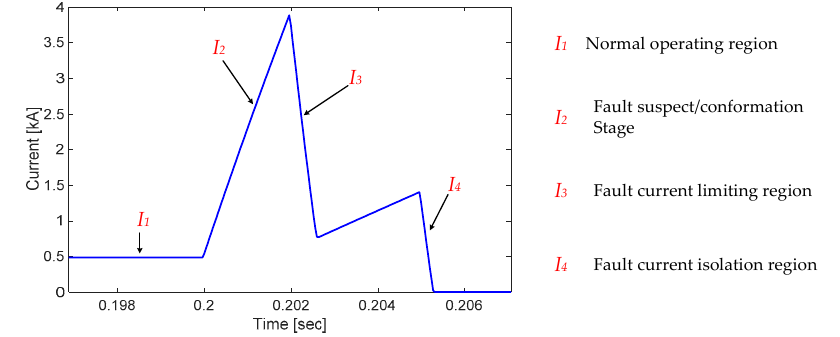
Figure 11. Overall response DC current.